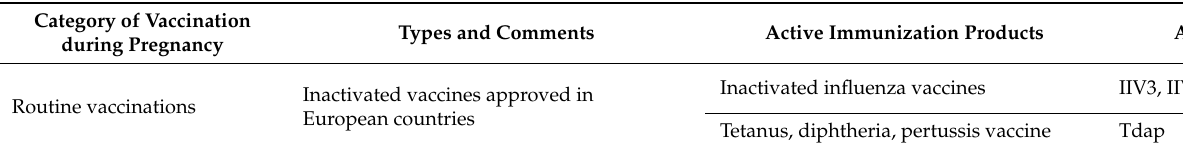
Table 1. Classification of vaccines during pregnancy according to their safety profiles and recommendations in vaccination programs or special circumstances and